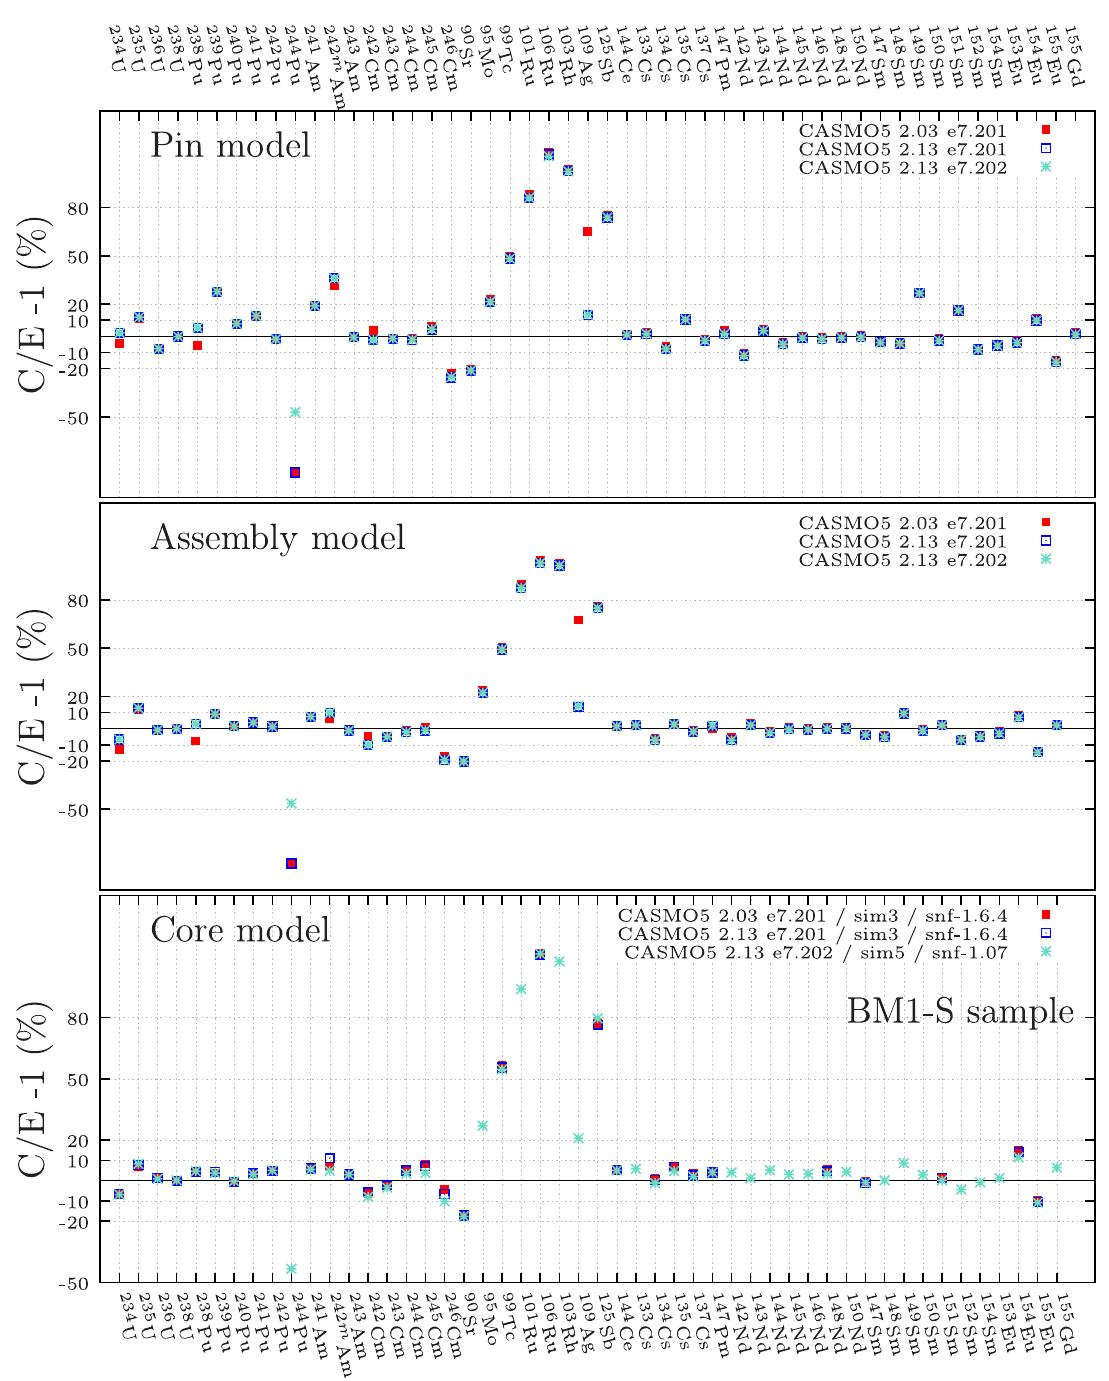
Fig. A.1. Comparisons between calculated and measured values from for each measured isotopes from different calculations for the BM1-S measurements (SCK-MOL); top: CASMO5 calculation only, bottom: 3D-1